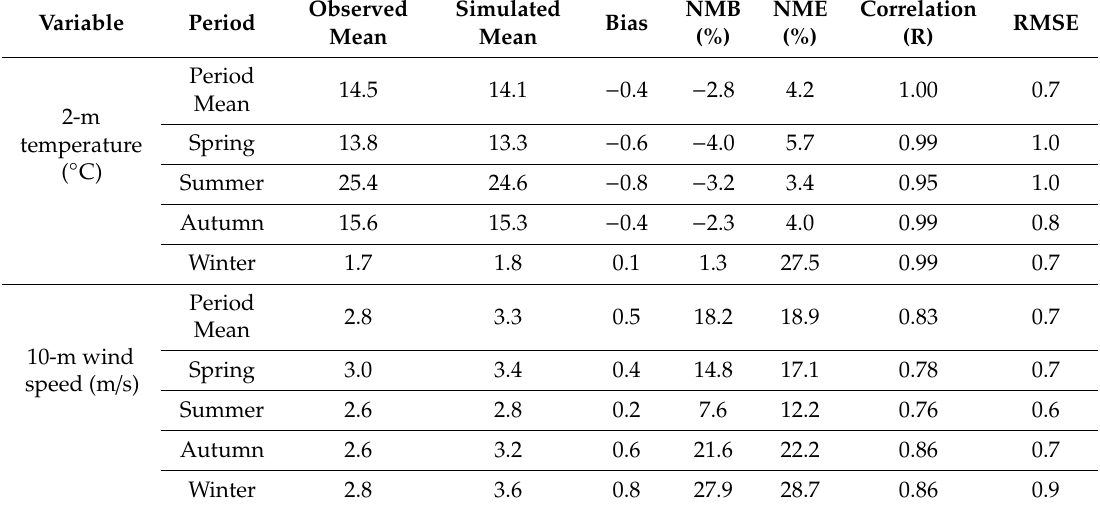
Table 3. Comparison of the observed and simulated daily mean meteorological variables performance statistics across 98 METAR sites from 2010 to 2017 in South Korea and